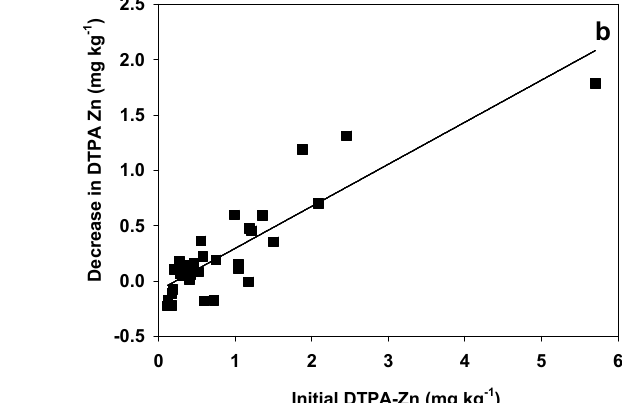
Figure 1. Cumulative Zn uptake by the four crops (expressed in mg kg –1 of soil) as a function of